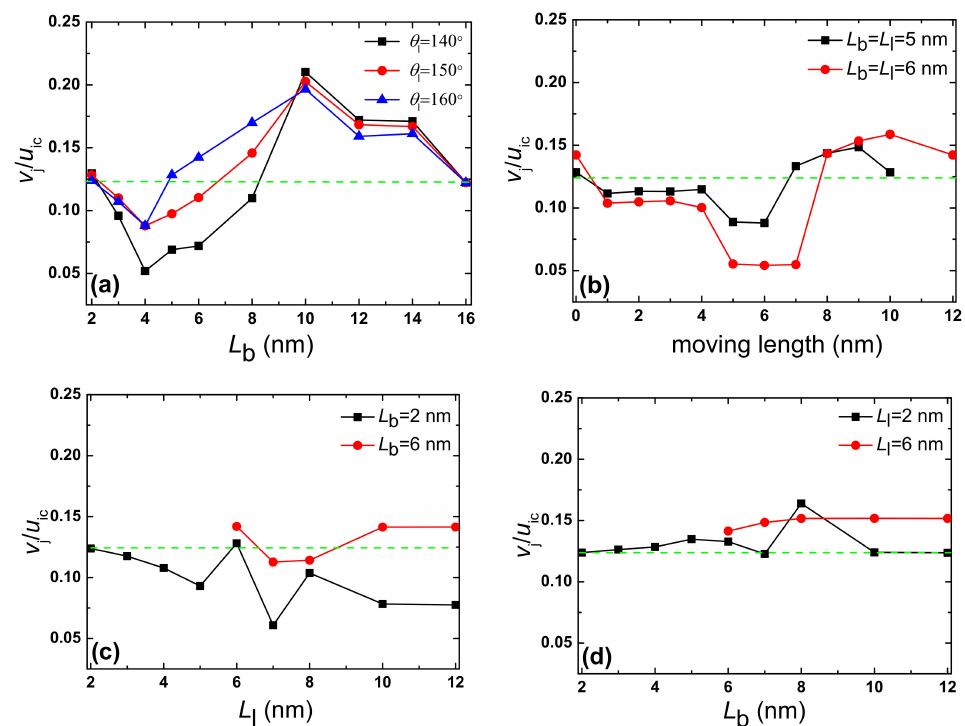
Figure 3. Dependency of the dimensionless jumping velocity of the coalesced droplets with respect to the effect of ( a ) strip widths and contact angles when L b = L l ; ( b ) moving length of the center of two droplets when L b = L l ; ( c ) hydrophilic strip width when the hydrophobic strip width is fixed; ( d ) the hydrophobic strip width when the hydrophilic strip width is fixed; where the dashed line denotes the limit value